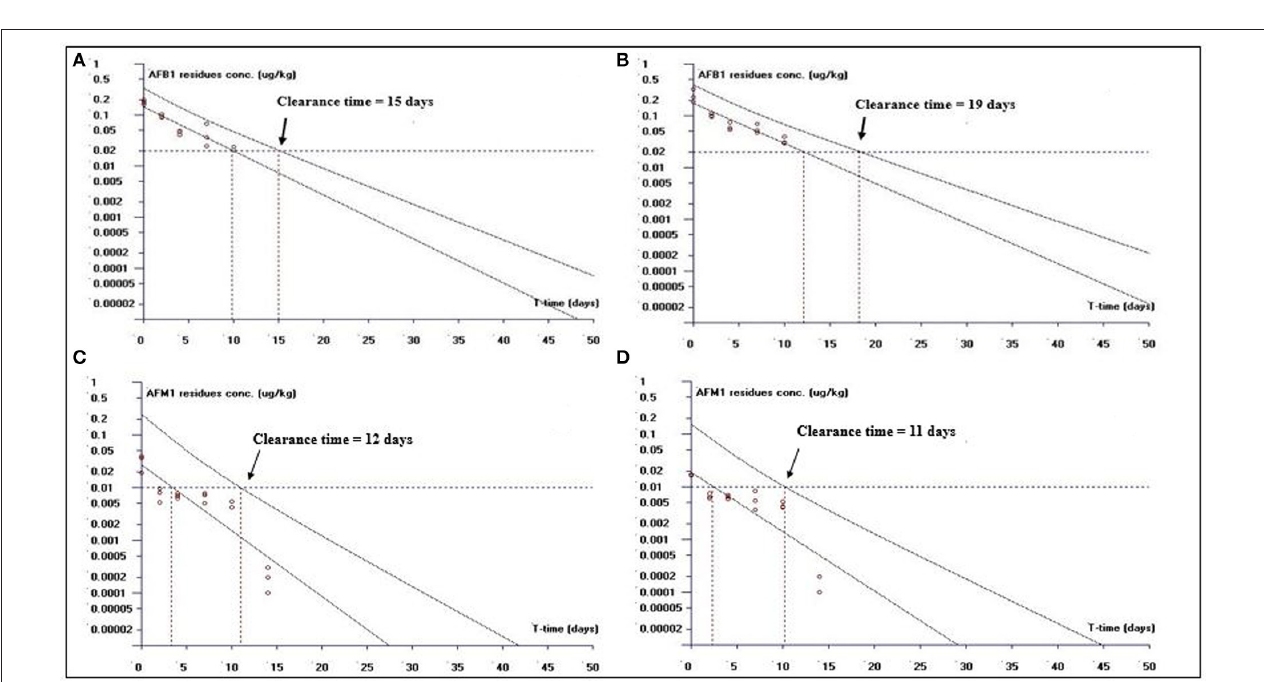
FIGURE 2 | The representative semi-logarithmic plot shows aflatoxin B1 (AFB1) and aflatoxin M1 (AFM1) residue concentrations for broiler kidney tissues vs. time , with the one-sided 95% upper tolerance limit in AFB1-fed group; (A) AFB1 residues (C) AFM1 residues and in curcumin + AFB1-fed group; (B) AFB1 residues (D) AFM1 residues. Small circles represent the residue concentrations of AFB1 and AFM1 for individual broiler chicken. The clearance time calculation based on the limit of quantification (LOQ; 0.02 µ g/kg for AFB1 and 0.01 µ g/kg for AFM1).